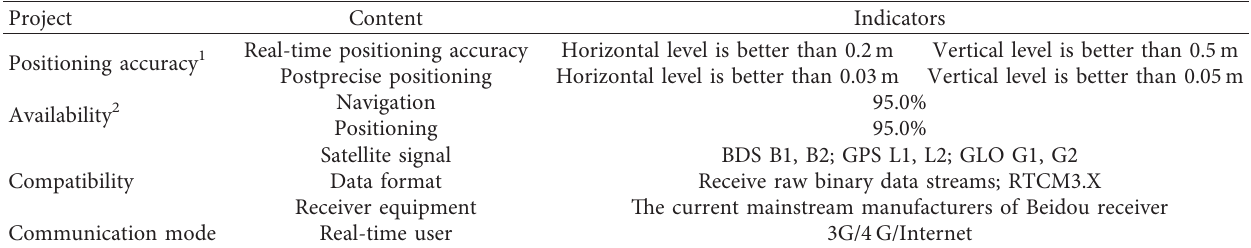
Table 5: System technical parameters.